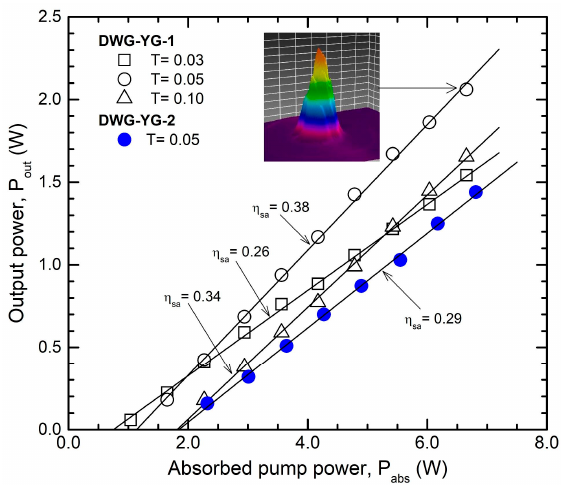
Figure 2. Cw output power, P out versus absorbed pump power, P abs for the waveguides inscribed in Nd:YAG. T: Out-coupling mirror (OCM) transmission. Inset is a 3D distribution of the laser beam at the maximum P out .